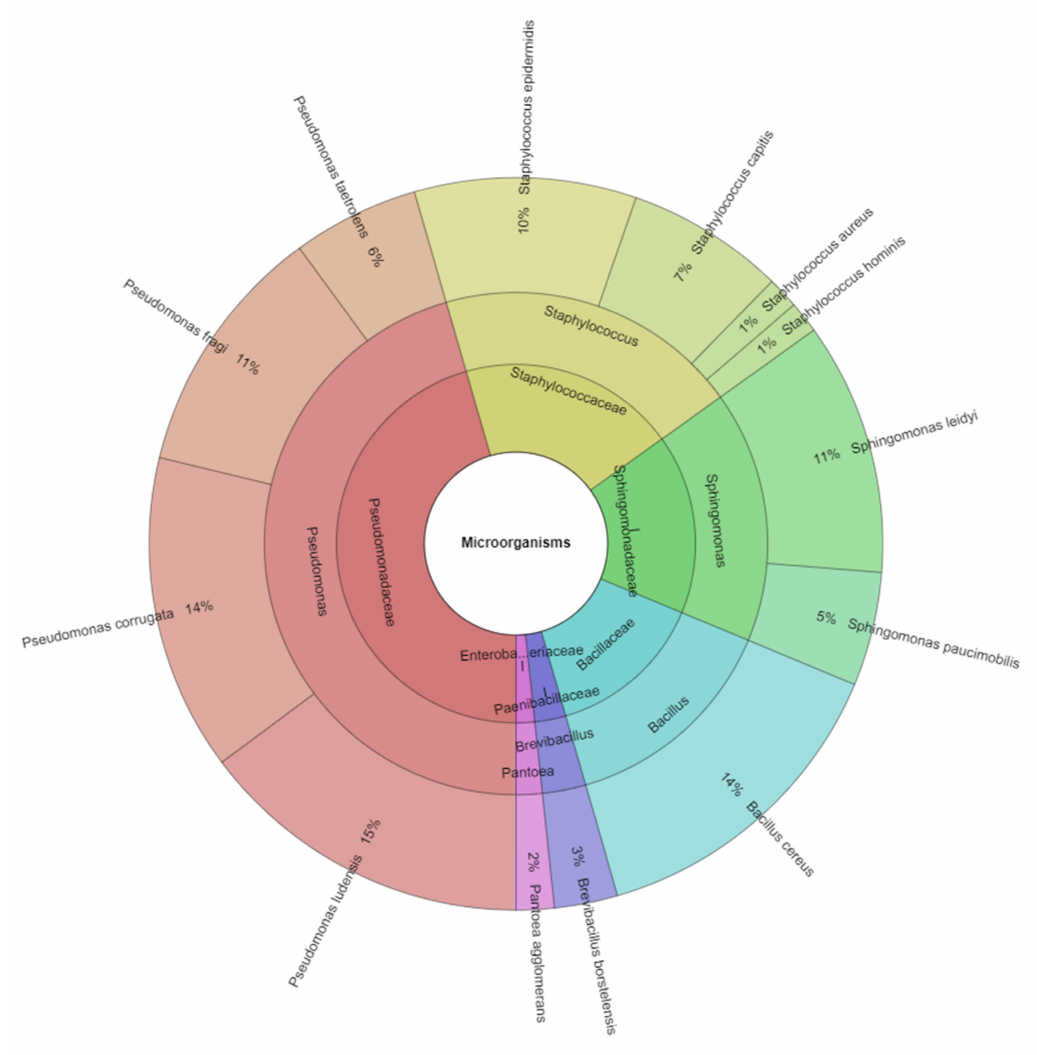
Figure 1. Identified species and family of bacteria in the deer meat. Table 5. Isolated bacteria from samples of deer meat stored under different packaging